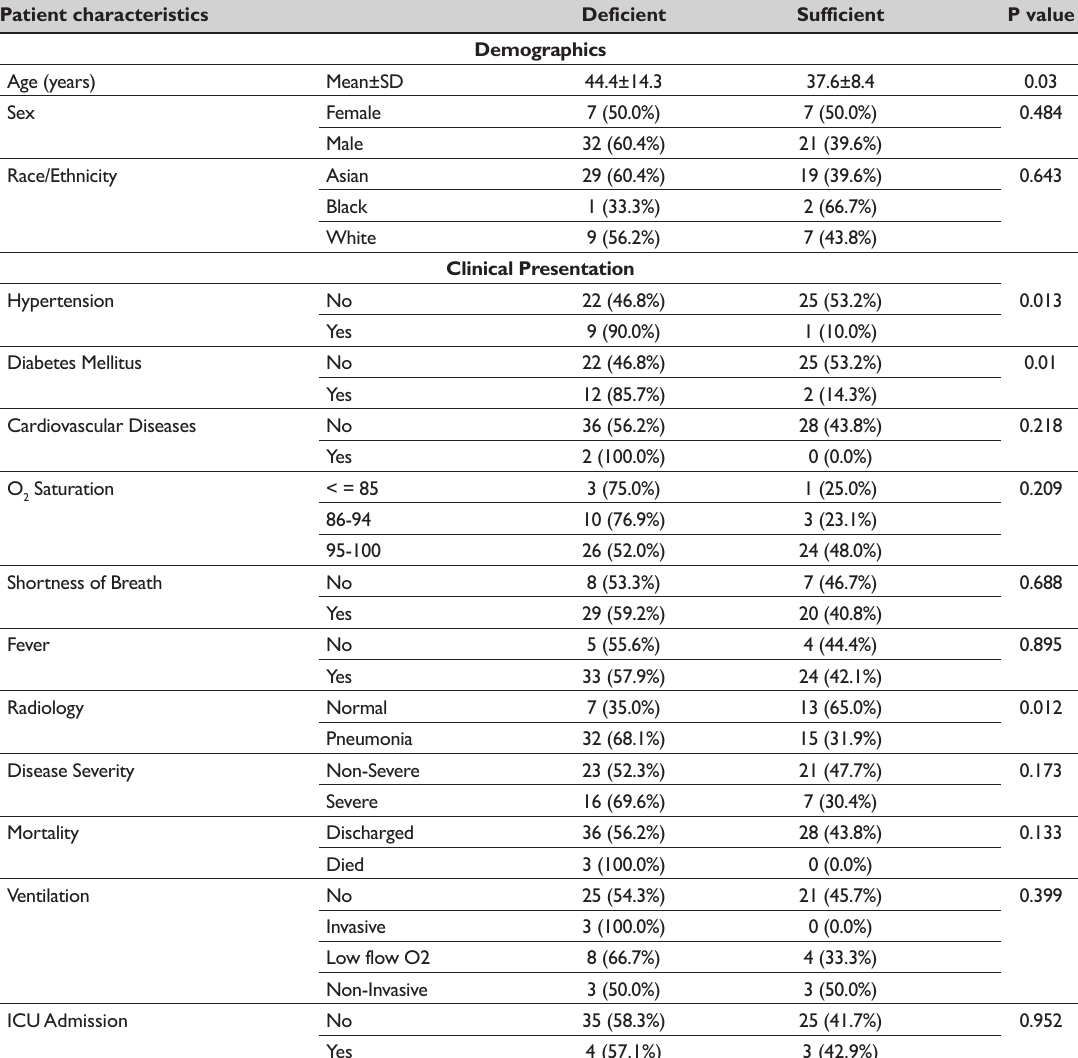
Table 2: Comparative analysis of the association between plasma vitamin C levels and patient demographics, clinical presentation, severity, mortality, ventilation, and ICU